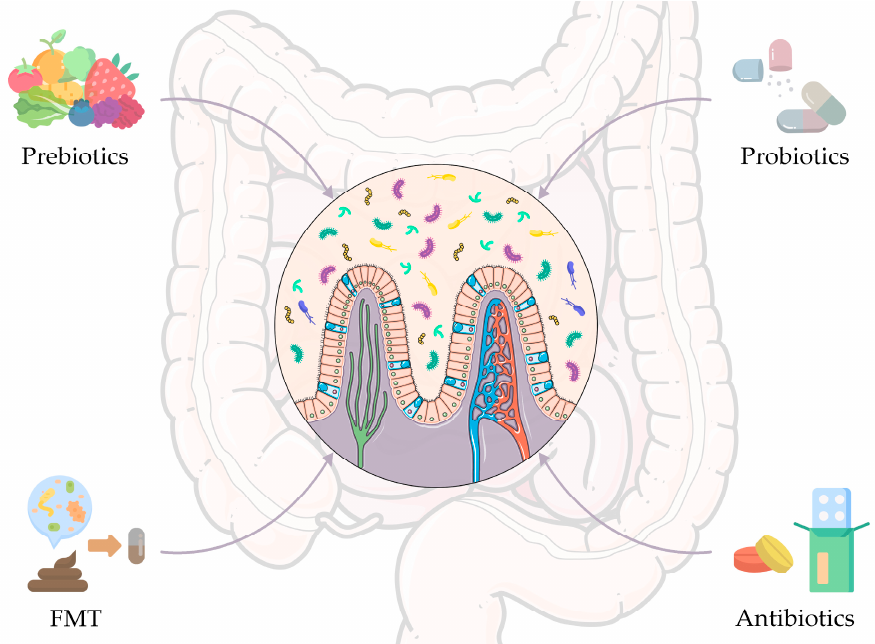
Figure 2. Gut microbiome-based intervention strategies to improve anticancer therapeutic outcomes. Strategies include prebiotics, probiotics, and antibiotics, i.e., the most widespread approaches historically, but also fecal microbiota transplantation (FMT), which has been assuming an important role in recent years. The figure was partly generated using Servier Medical Art, provided by Servier, licensed under a Creative Commons Attribution 3.0 unported license and images from Flaticon resurces.